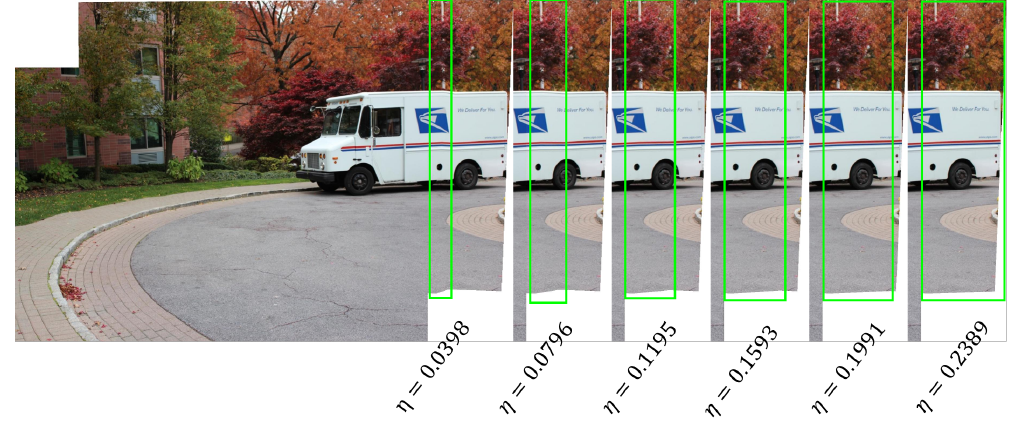
Figure 4. Different transition effects with different η . The green boxes represent the approximate transition region. A small η will cause an unnatural transition, so we try to make the transition area cover the nonoverlapping region on the right side.